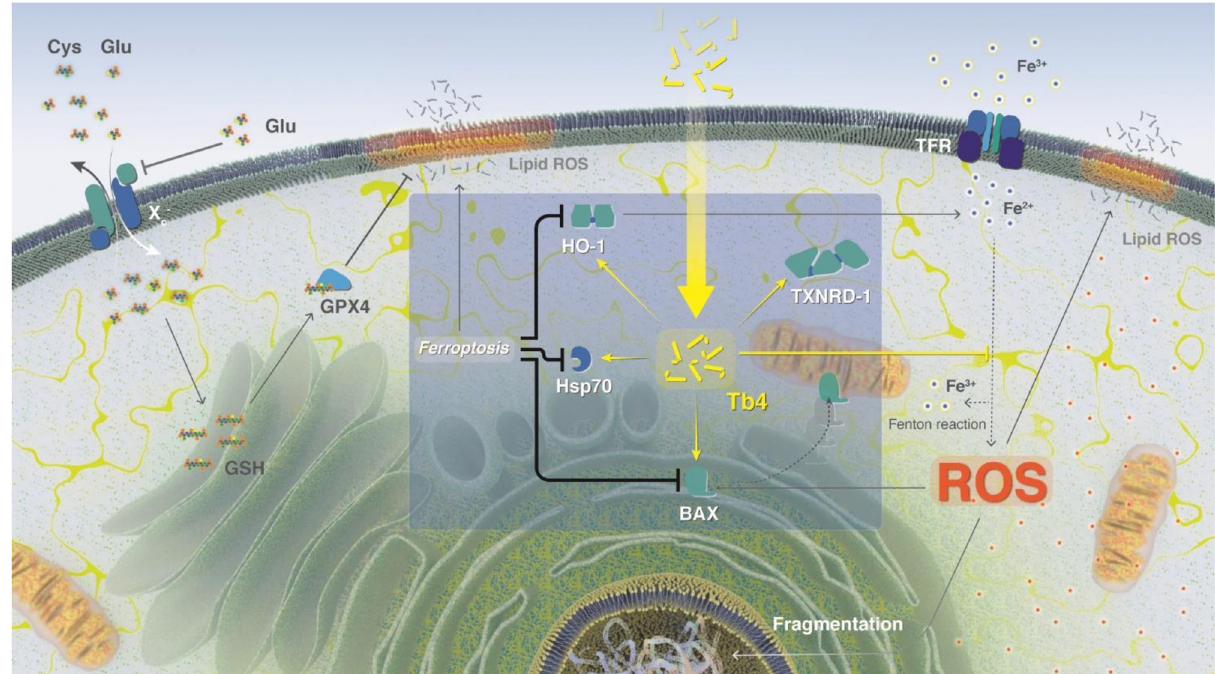
Scheme 2. T β 4 inhibitory activity of ferroptosis. An excess of L-Glu in the extracellular